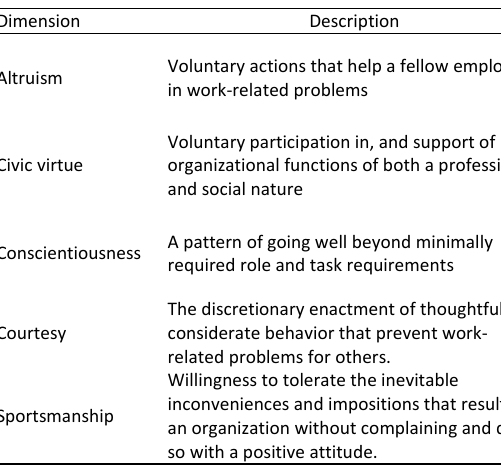
Table 2: Dimensions of organizational citizenship behavior Table 2. Dimensions of organizational citizenship